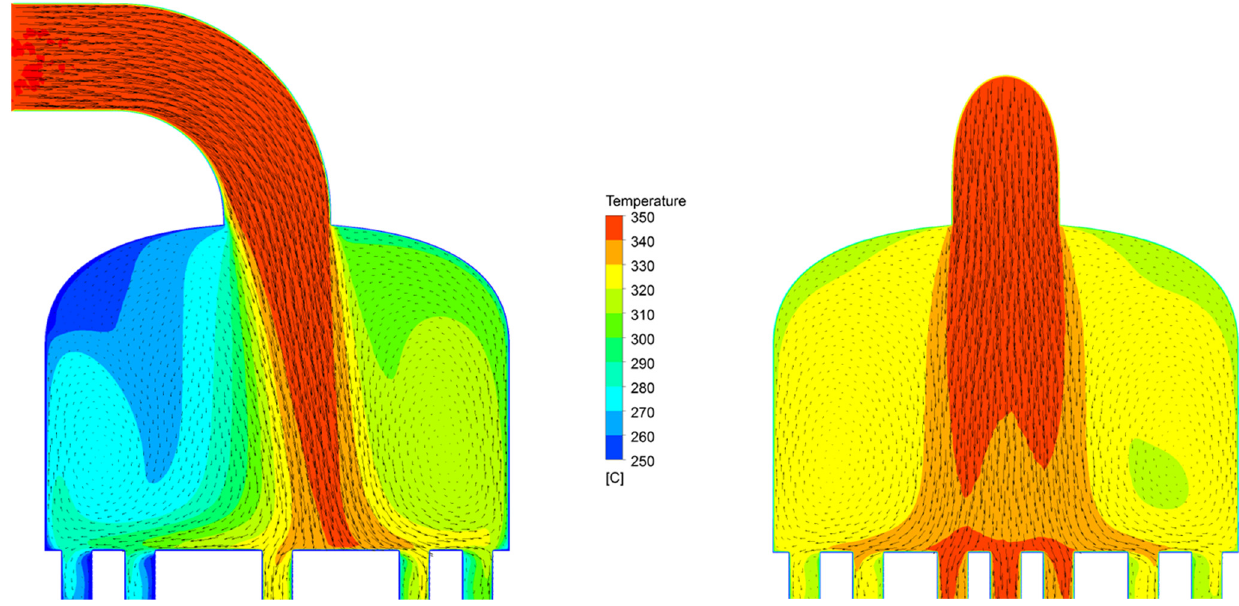
Figure 7. Syngas temperature distribution within the intake header for the clean heat exchanger.